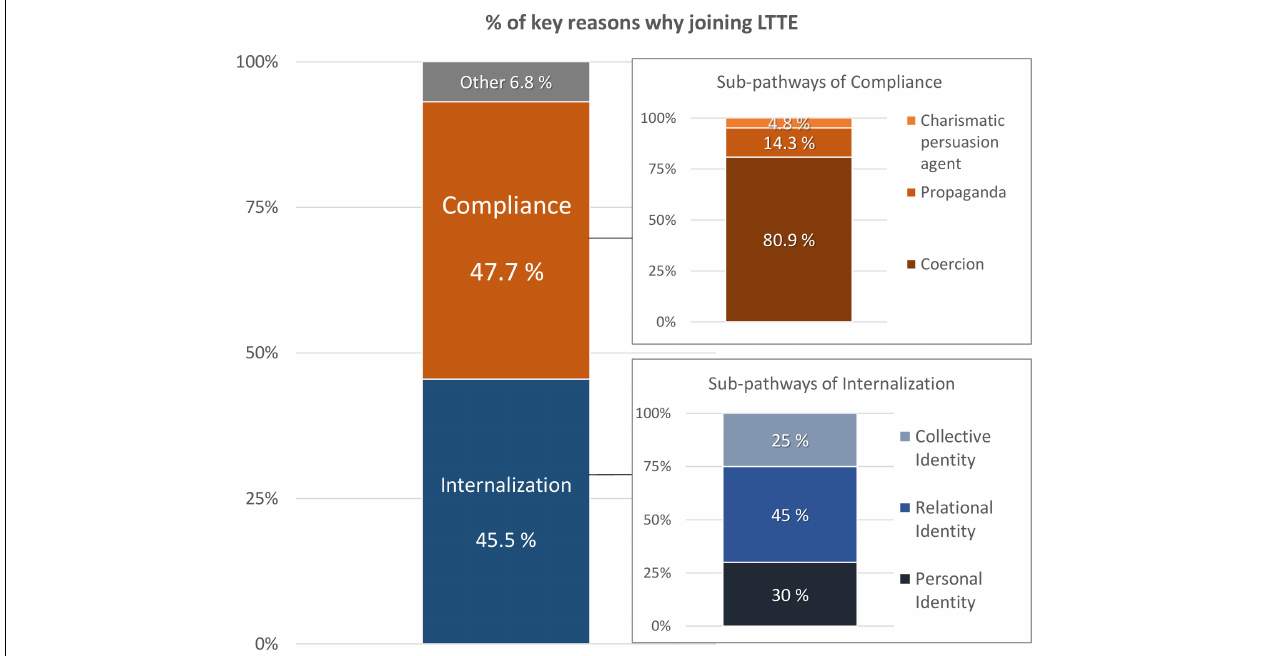
FIGURE 1 | Percent breakdown of key reasons that former members joined